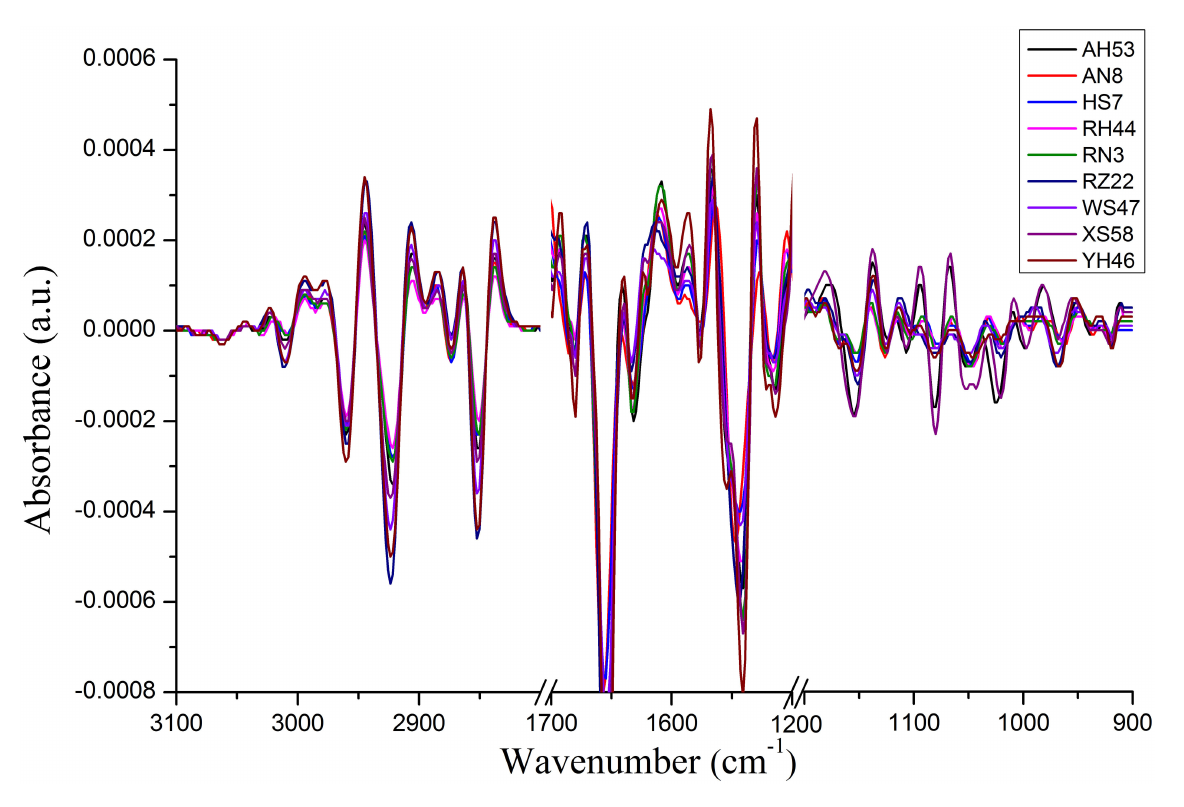
FIGURE3 The second derivative FTIR spectra collected from each Spirulina